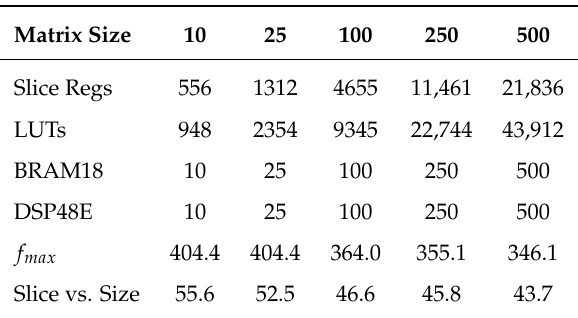
Table 3. Resources used by different hardware cores synthesized in a xc7vx485tffg1157 Virtex7 device with an 18-bit data